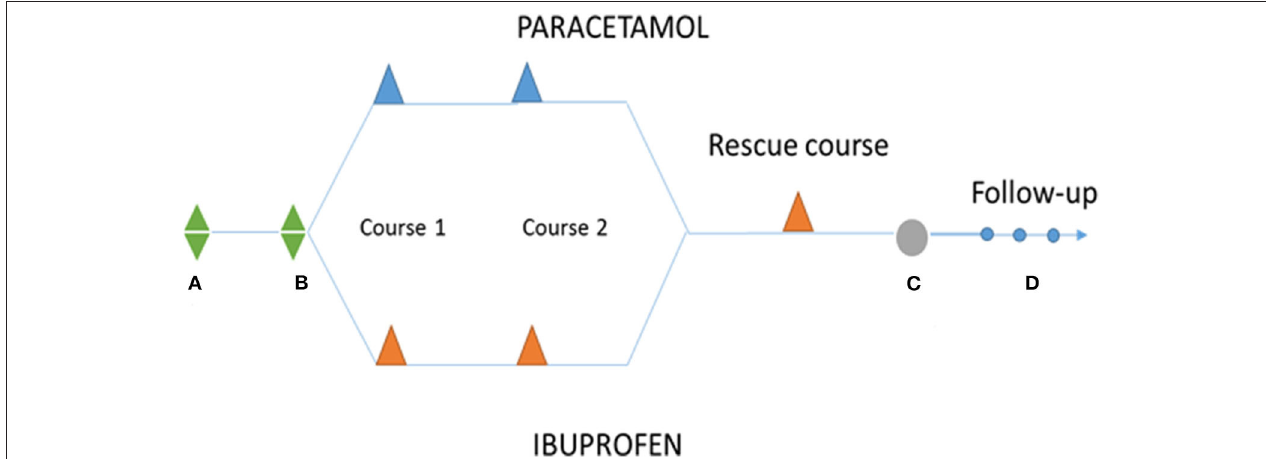
FIGURE 1 | Diagram of study. (A) Birth; (B) diagnostic and randomization; The PARACETAMOL group will receive IV doses of 15 mg/kg administered every 6h for 3 days (maximum two courses = 6 days of treatment). The IBUPROFEN group (control group) will receive an initial dose of IV 10 mg/kg followed by 5 mg/kg at 24 and 48h (the three doses are considered a treatment course, maximum two courses). (C) Surgical close. (D) FOLLOW-UP: 40 weeks, 12 months, and 24 months.